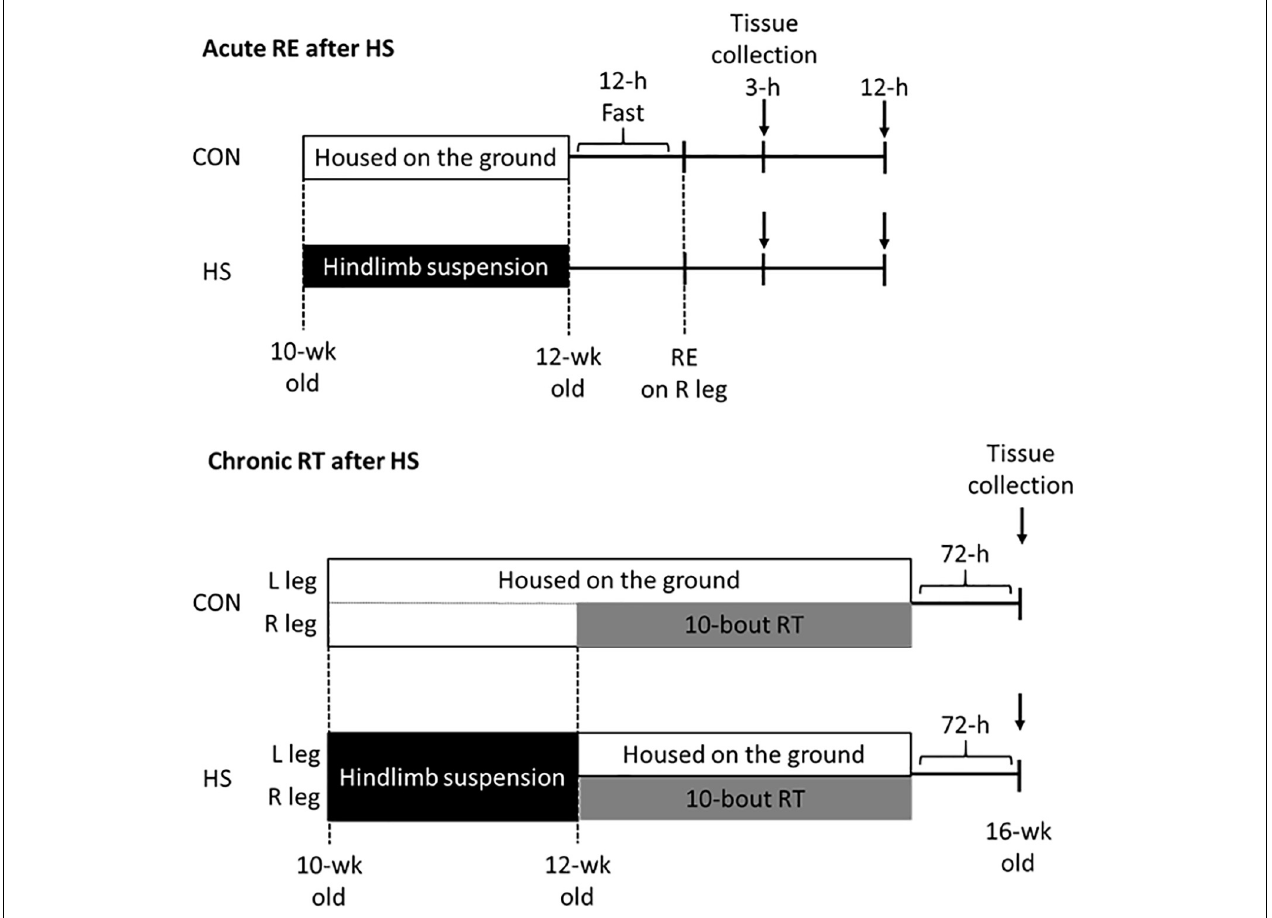
FIGURE 1 | Schematic representation of hindlimb suspension and exercise training intervention. CON; control group. HS; hindlimb suspension group. RE; acute resistance exercise. RT; resistance